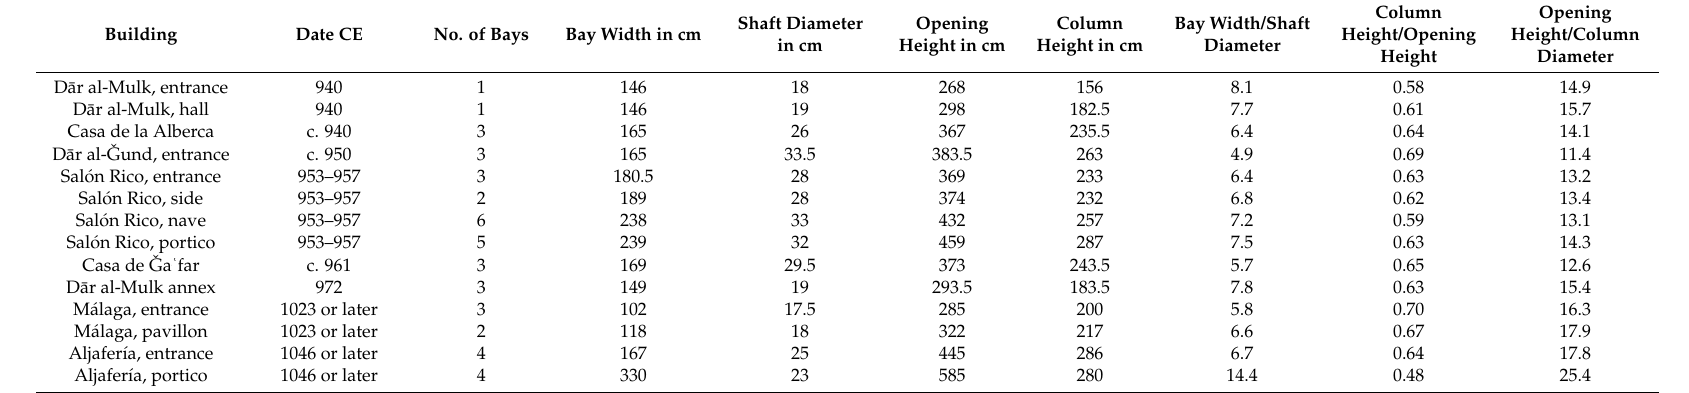
Table 2. Measurements and proportions of arcades of the 10th and 11th century.